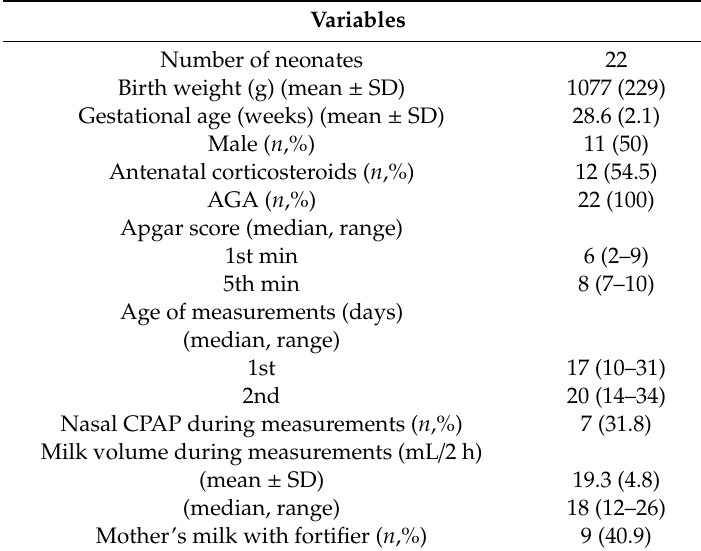
Table 1. Basic characteristics of the study neonates.